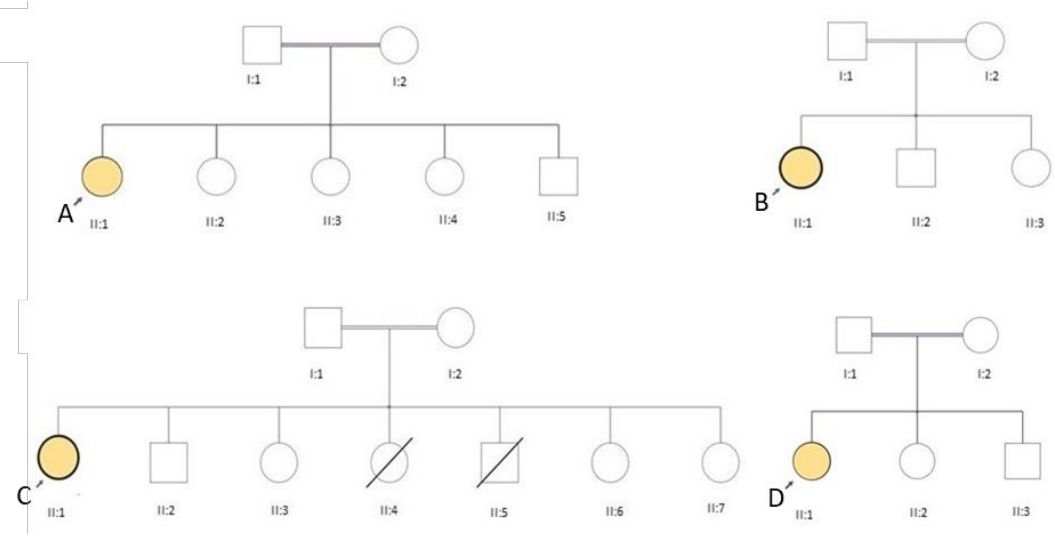
Figure 1. Pedigrees of our four LGMD R17 patients carrying the c.1_9del mutation in homozygosis. Patients A, B, C and D are indicated.